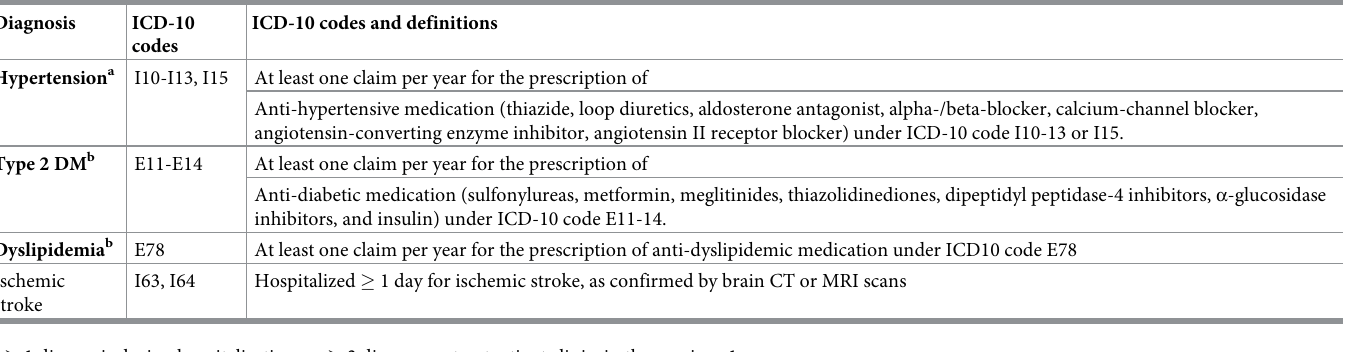
Table 1. Definitions of ischemic stroke and